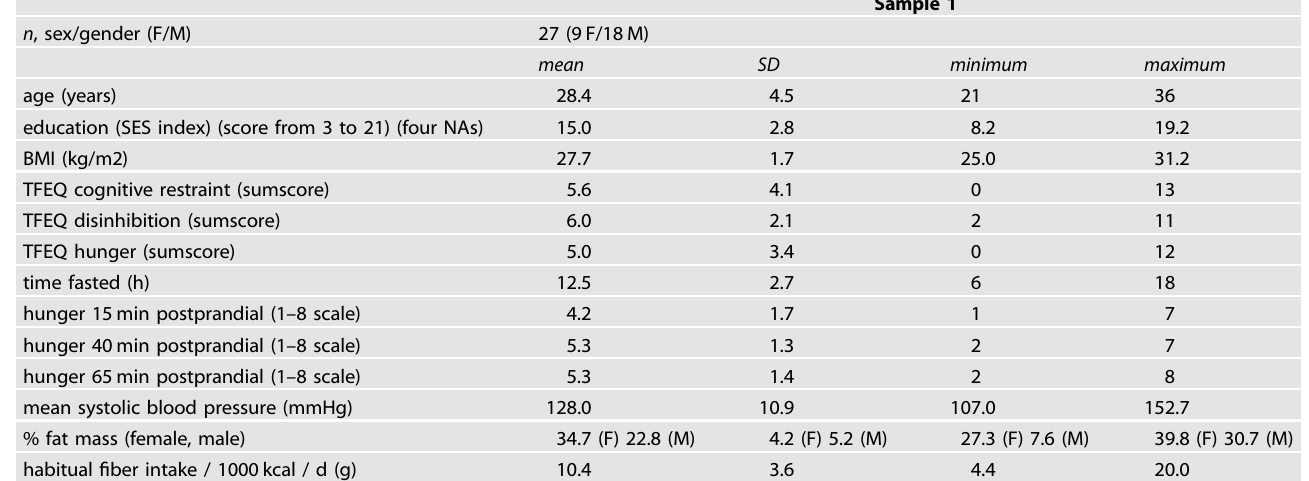
Table 1. Descriptives for sample